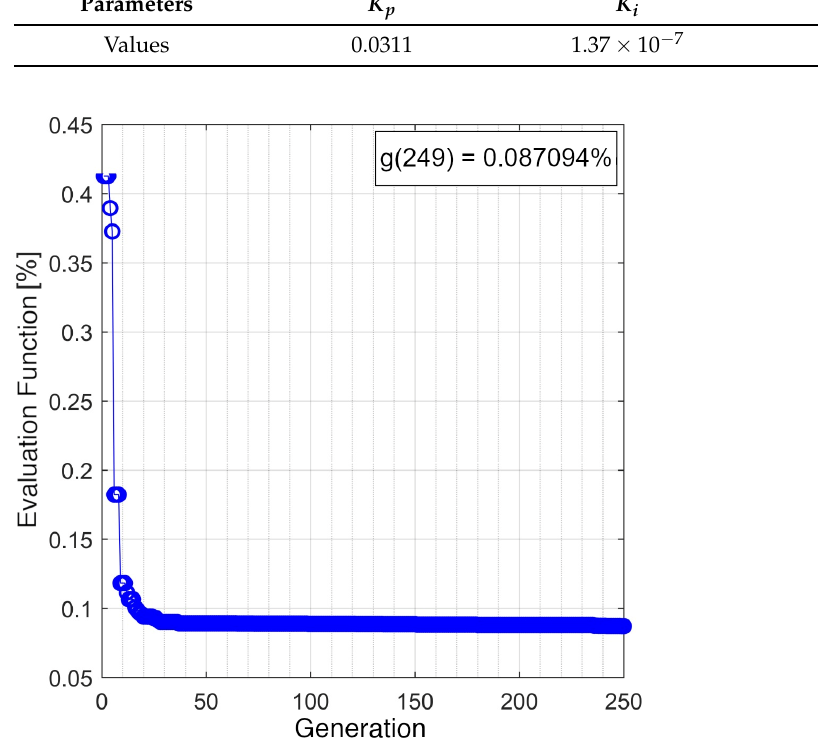
Figure 8. Presentation of the evaluation function values in the optimization process of the PID